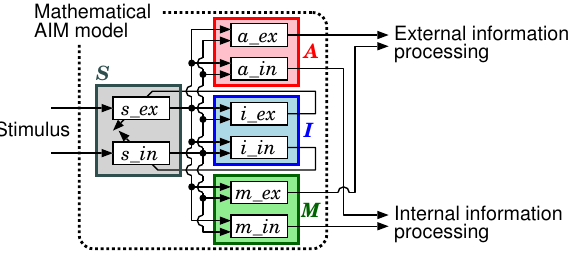
Figure 5. Mathematical AIM